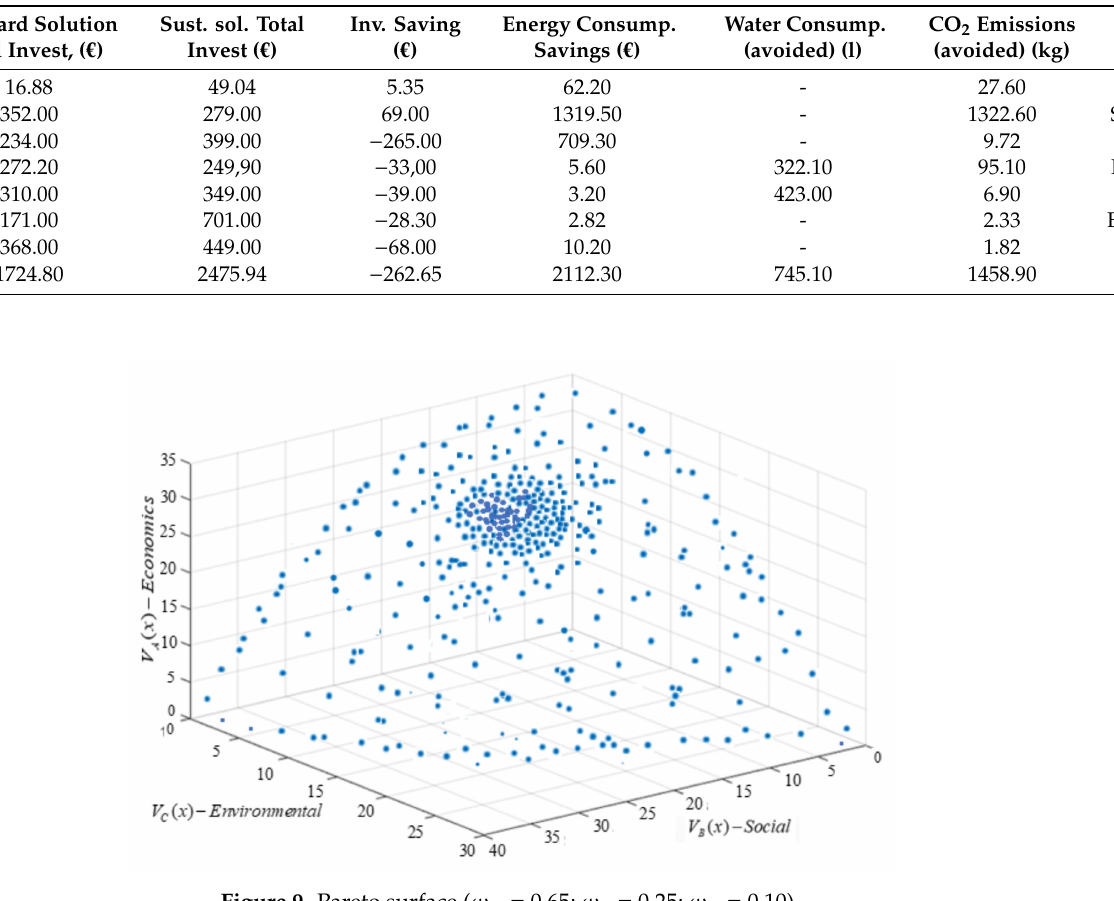
Table 5. One of sustainable solutions achieved from the Pareto surface ( ω A = 0.65, ω B = 0.25, and ω C = 0.10).